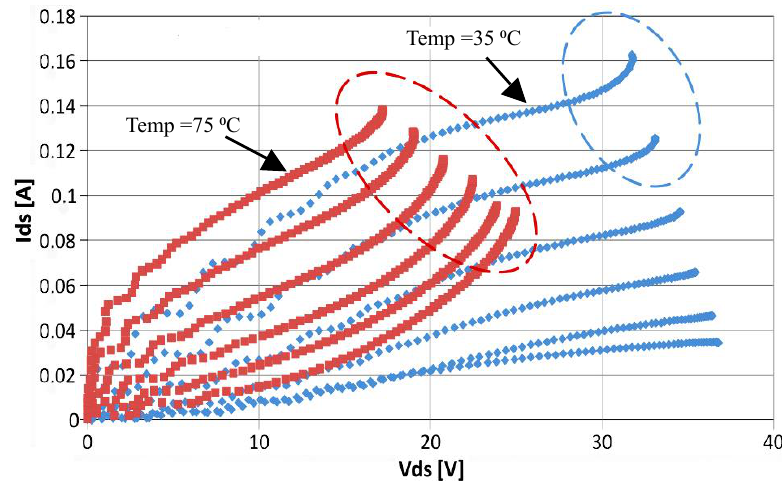
Figure 38. Output characteristics of the device reveal a runaway mechanism on the ellipse area with different temperatures. Reproduce with permission [167]. Copyright 2012, Elsevier.